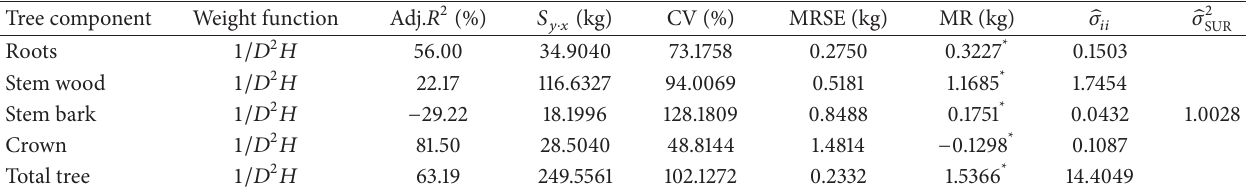
Table 3: Fit statistics of SUR using the system of the best linear